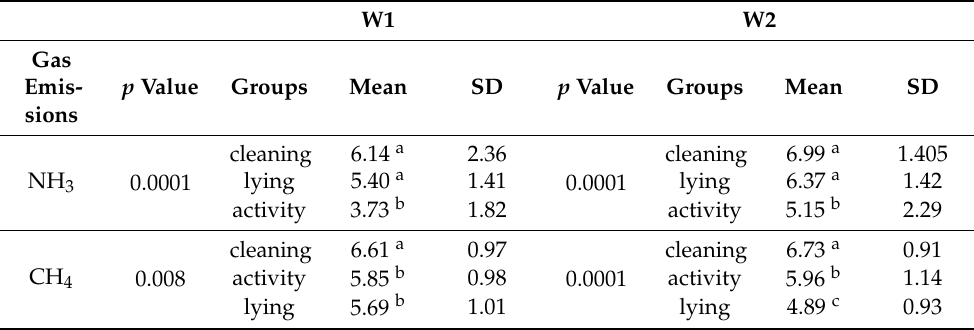
Table 4. Results of statistical analyses for gas emissions at different groups of cow activity during W1 and W2. W1